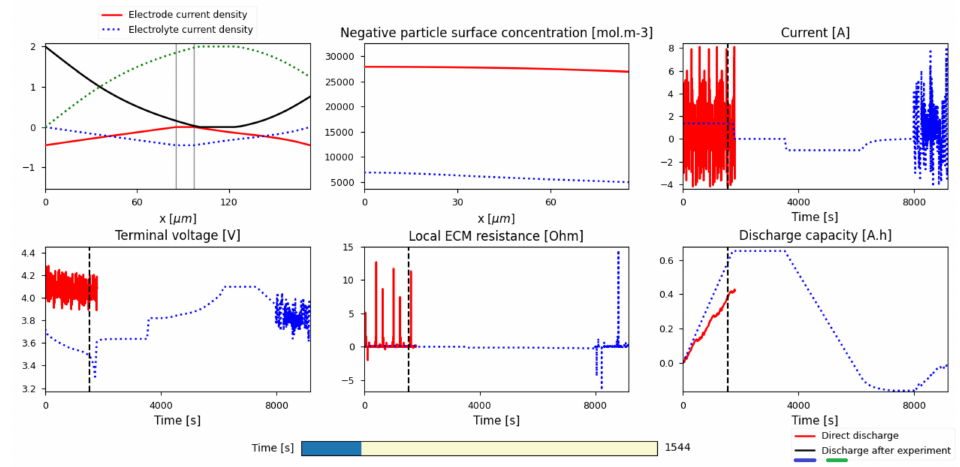
Figure 5. Comparison between output parameters of two discharge